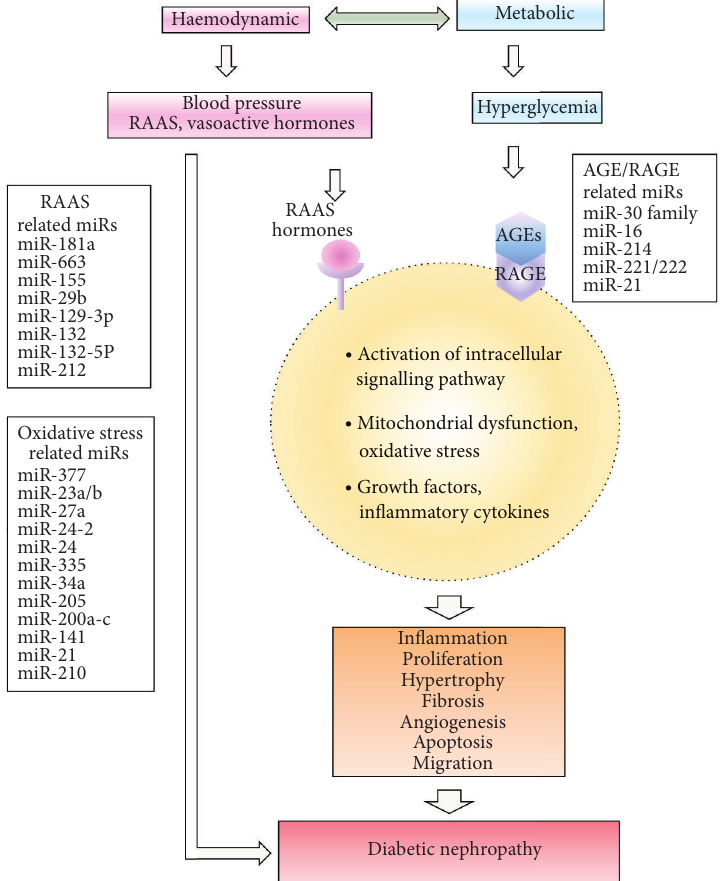
Figure 1: Schematic overview of mechanisms and microRNAs that are related to RAAS, AGE/RAGE, or oxidative stress contributing to diabetic nephropathy. AGE: advanced glycation end-product; miR: microRNA; RAAS: renin-angiotensin-aldosterone system; RAGE: receptor of